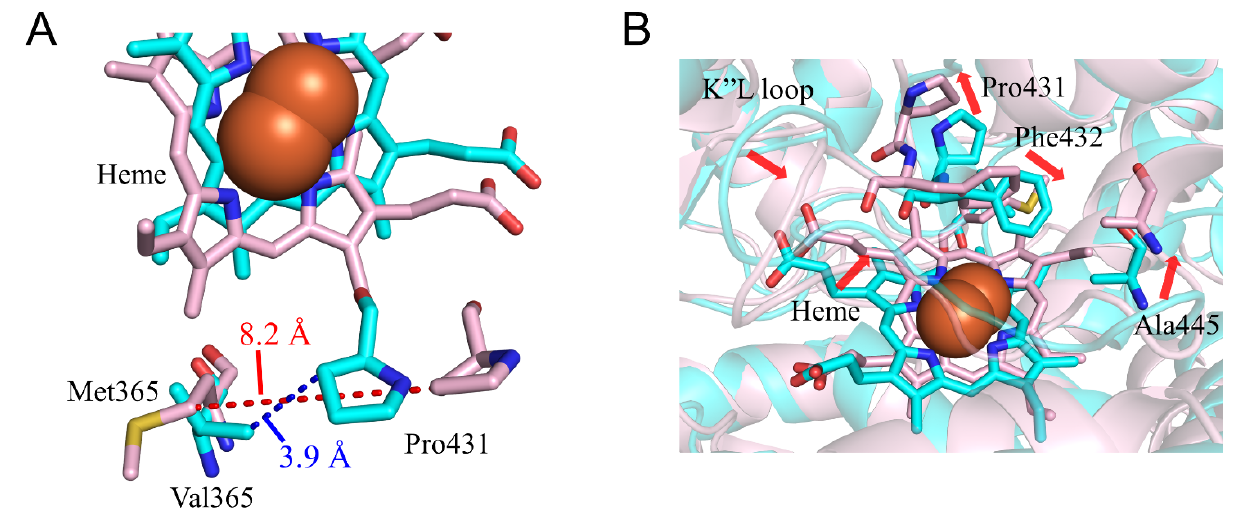
Figure 7. Structural change in CYP2A6.17 ( A , B ). The wild type and CYP2A6.17 are shown in cyan and pink, respectively. Nitrogen, oxygen, and hydrogen are displayed in blue, red, and white, respectively, in the stick model. Iron is shown as an orange sphere by a model written as van der Waals radius. The red and blue dotted lines indicate the distances between Val/Met365 and Pro431. The red arrows indicate the shift in CYP2A6.17. All hydrogen atoms are omitted.